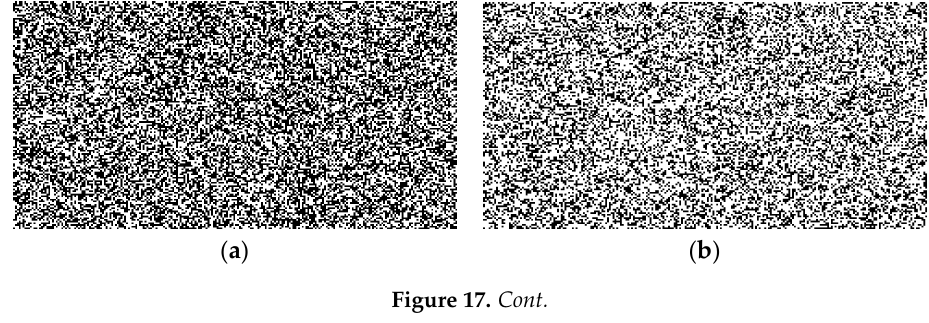
Figure 16. Extracted data image ( a ) Image 1, ( b ) Image 2, ( c ) Image 3, ( d ) Image 4.